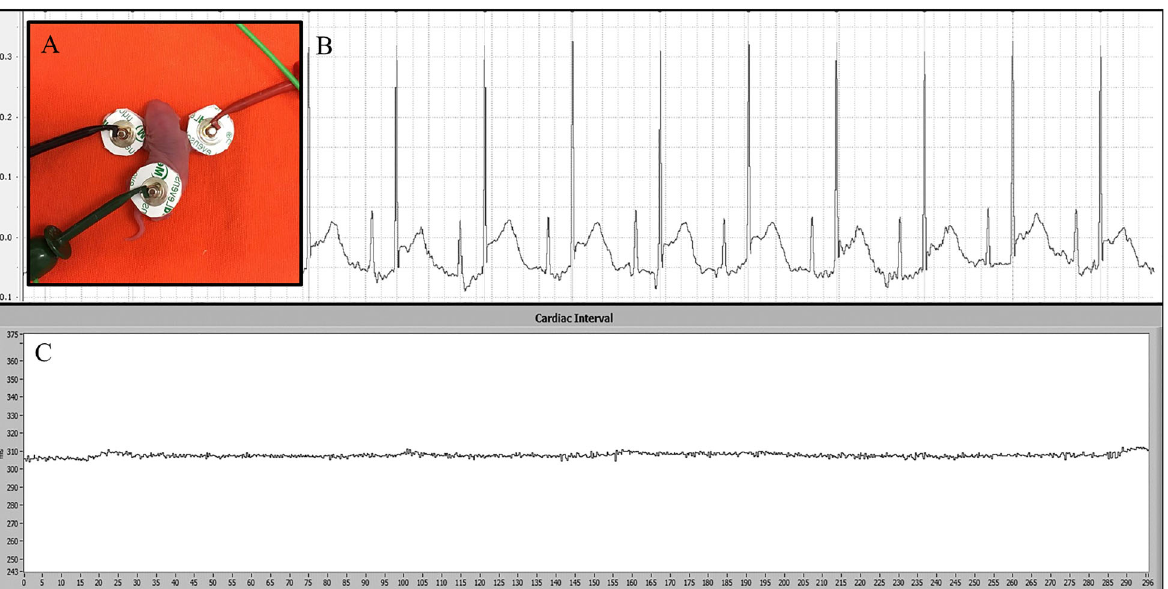
Figure 1. A , Electrocardiographic (ECG) data acquisition in a neonate rat. B , ECG wave signals. C , Tachogram obtained by cardiac interval